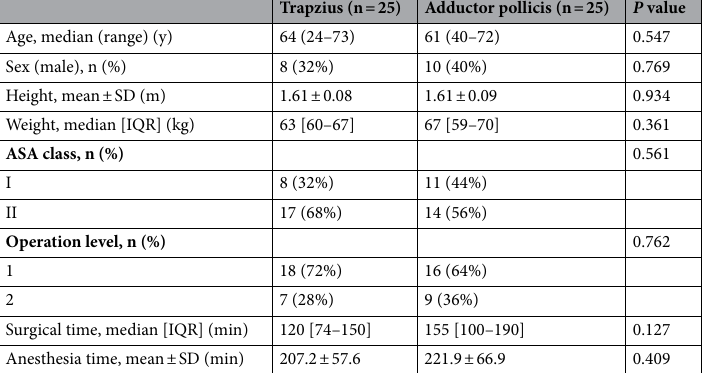
Trapzius (n = 25) Adductor pollicis (n = 25) P value